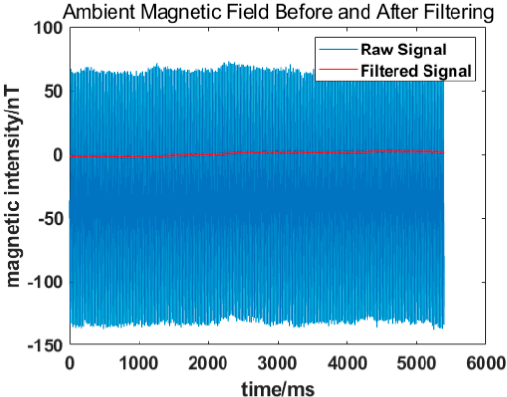
Figure 3. Ambient magnetic field of the shield chamber before/after filtering. Table 1. Comparison of the ambient magnetic field before/after filtering.